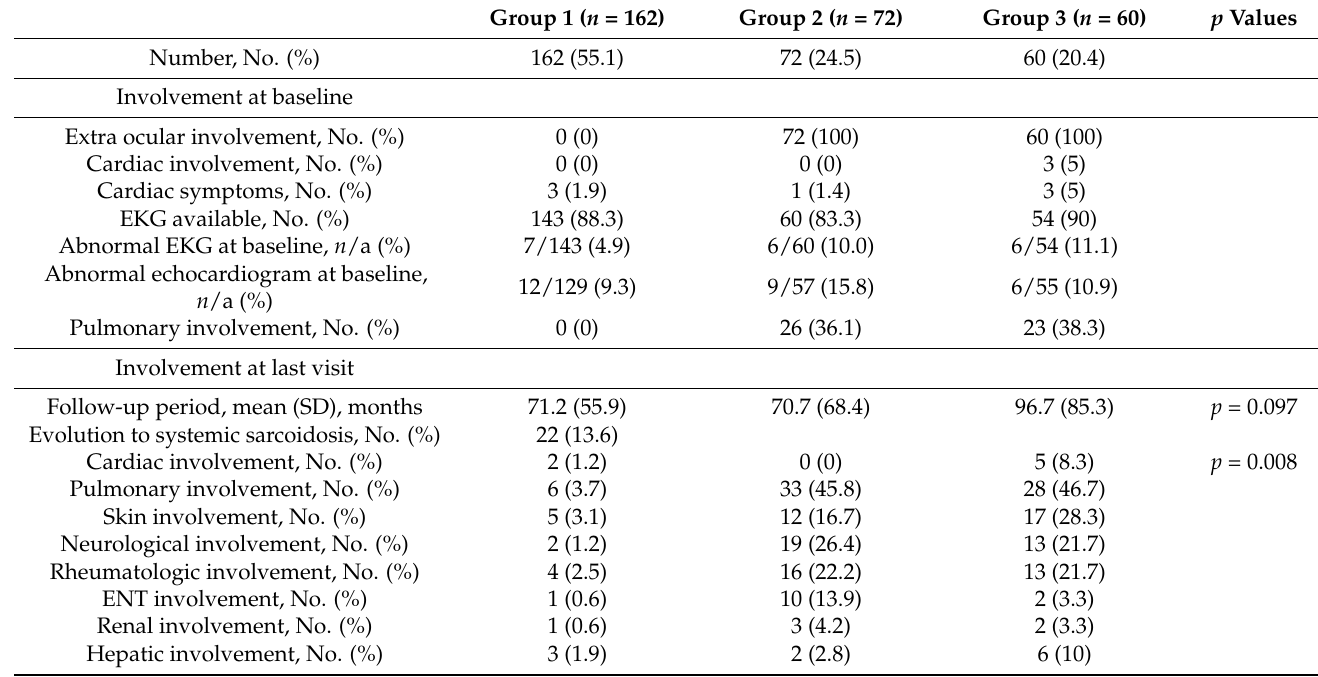
Table 2. Cardiac and systemic involvement at baseline and last visit between 3 groups of sarcoid uveitis, defined according to their